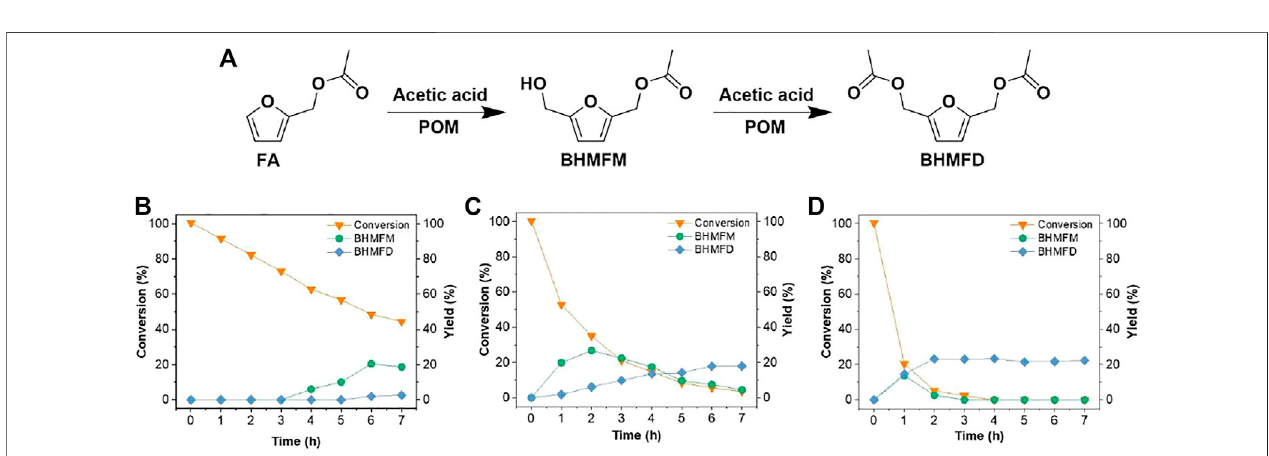
FIGURE 2 | (A) Synthesis pathway of BHMFM and BHMFD from FA; time-dependent conversion of FA and yield of BHMFM and BHMFD at (B) 80 ° C; (C) 100 ° C; and (D) 120 ° C. Other hydroxylmethylation reaction conditions: 0.4 mmol FA, 1.7 mmol paraformaldehyde and 35.0 mmol CH 3